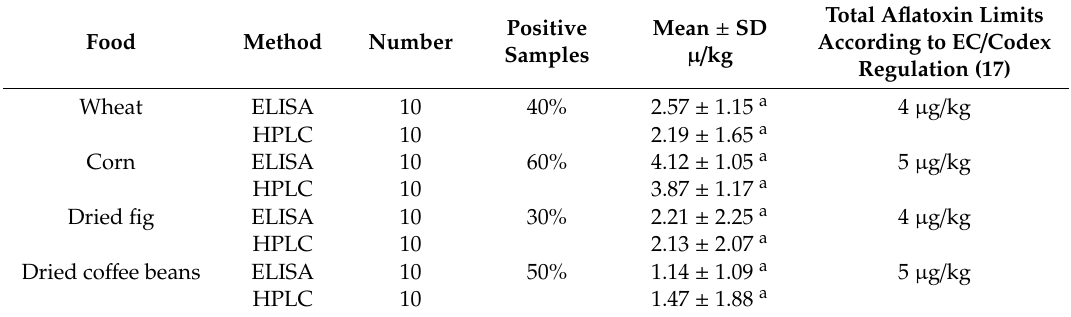
Table 5. Total aflatoxin levels in di ff erent food samples by using ELISA and HPLC. No di ff erences have been observed between the ELISA and HPLC results ( p > 0.05). SD is for: standard deviation. Food Method Number